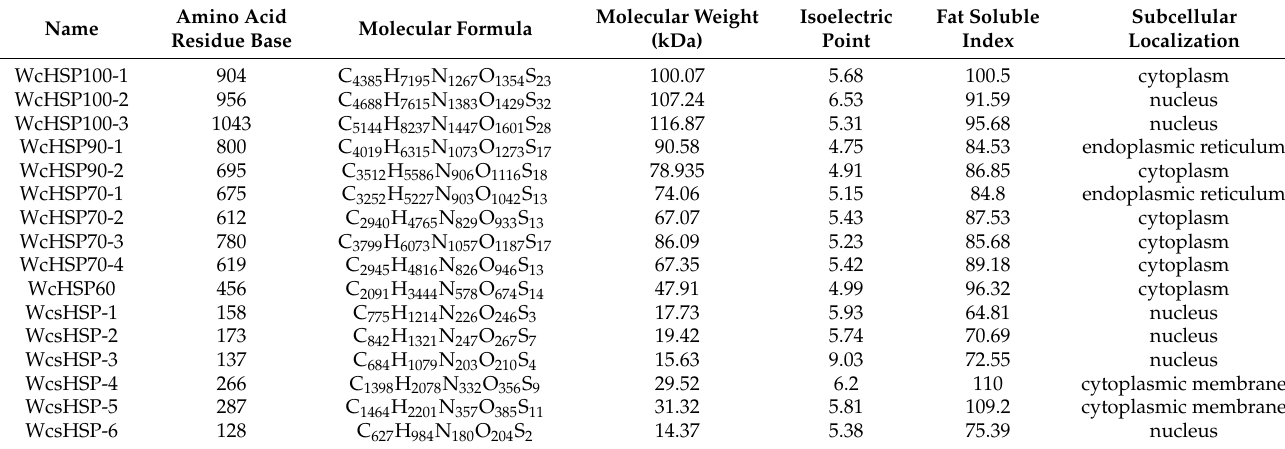
Table 1. Physicochemical properties of heat shock proteins in W. cocos